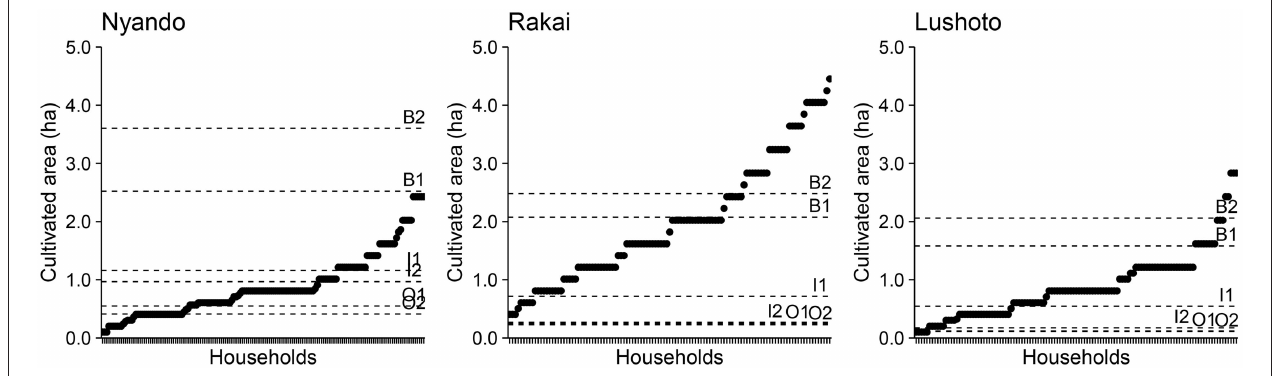
FIGURE 6 | Distributions of current cultivated areas per household as reported in the survey, and the cultivated area required to attain a living income (viable farm size; dashed horizontal lines) for six scenarios. Full scenario names: B1: baseline yields, B2: baseline yields - costs, I1: improved yields, I2: profitable crops, O1: livestock income, O2: off-farm income